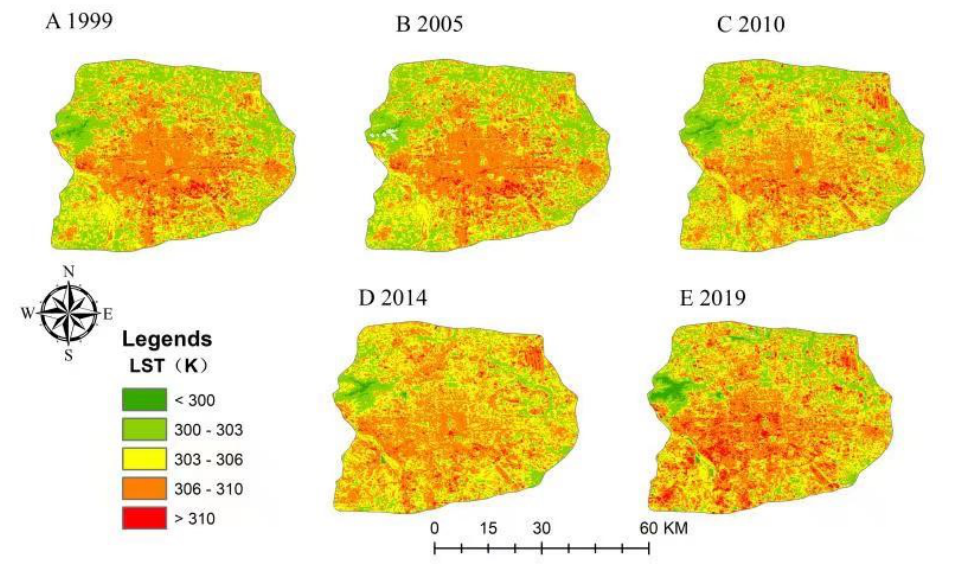
Fig. 4 LST in Beijing from 1999 to 2019. LST, land surface